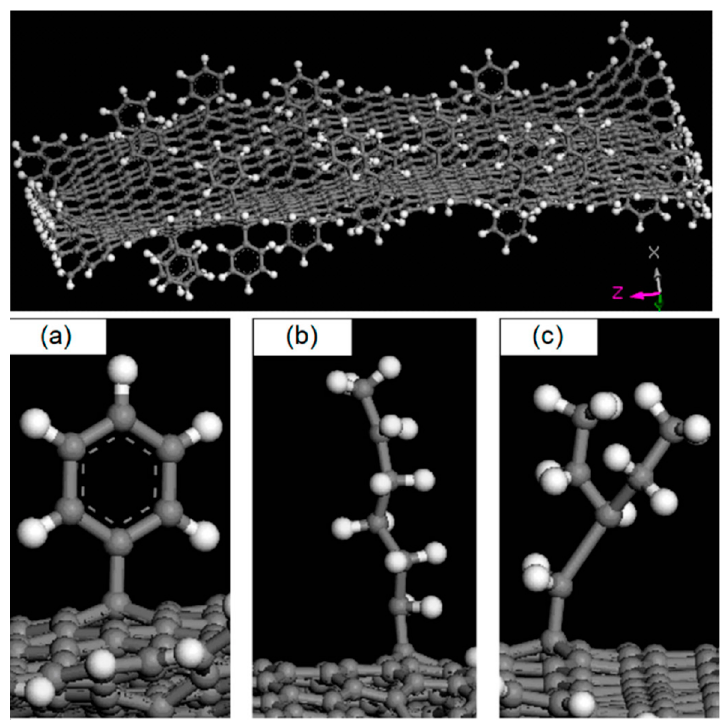
Figure 4. Illustration of graphene with different functionalized groups ( a ) phenyl groups ( b ) –C 6 H 13 and ( c ) –C 2 H 4 (–C 2 H 5 ) 2 . Reprinted with permission [27].